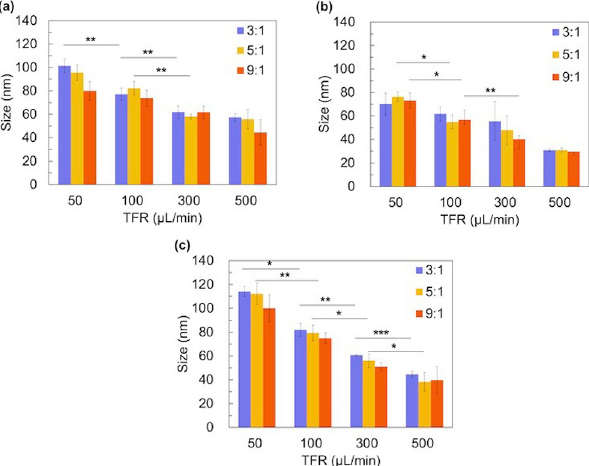
Fig 2. Effect of the flow condition on the NP size. (a) PLGA, (b) PEG-PLGA, and (c) blend. The FRR ranges from 3:1 to 9:1, whereas TFR ranges from 50 to 500 μ L/min. The error bars represent the standard deviations calculated from the repeated NP preparation experiments at least three times. P-values: ��� � 0.0001; �� � 0.01, � <